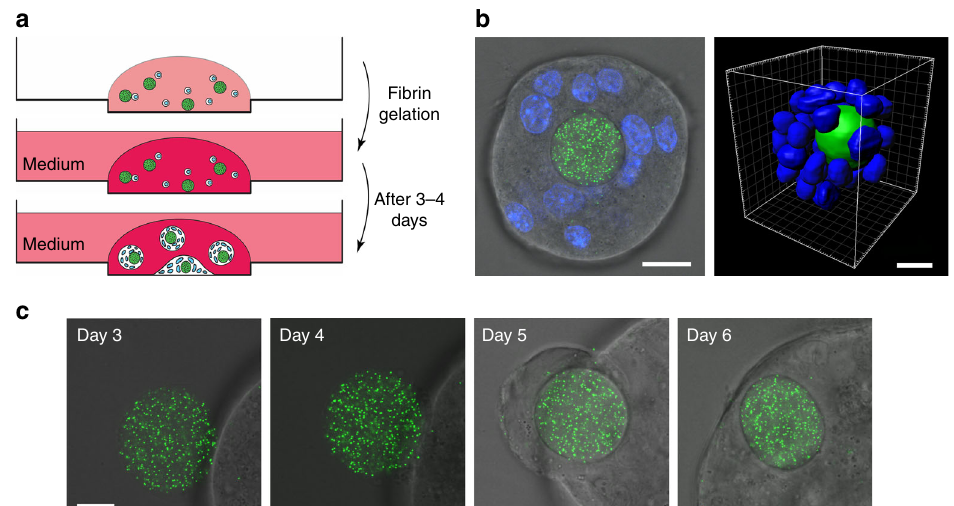
Fig. 6 Elastic round microgels embedded in a melanoma cell colony. a Schematics of steps in preparing an elastic round microgel (ERMG) encapsulated in a melanoma colony of tumor-repopulating cells (TRCs) (spheroid) in 3D fi brin gels. b A confocal section of an embedded microgel (Young ’ s moduli of 1440 Pa) and its corresponding three dimensional rendering view (green, microgel; blue, nucleus). c Encapsulation processes of an ERMG by melanoma cells as a function of culturing time. Note shape changes of the ERMG while the cells are encapsulating it. All scale bars, 15 µ